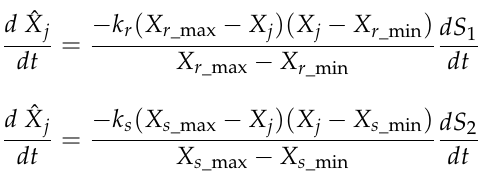
Figure 5. The observed error of the function described by the concentration distribution. By differentiating both sides of Equations (12) and (13), the relation between the component concentration and the moving velocity of the distribution curve (the velocity of the inflection points) can be